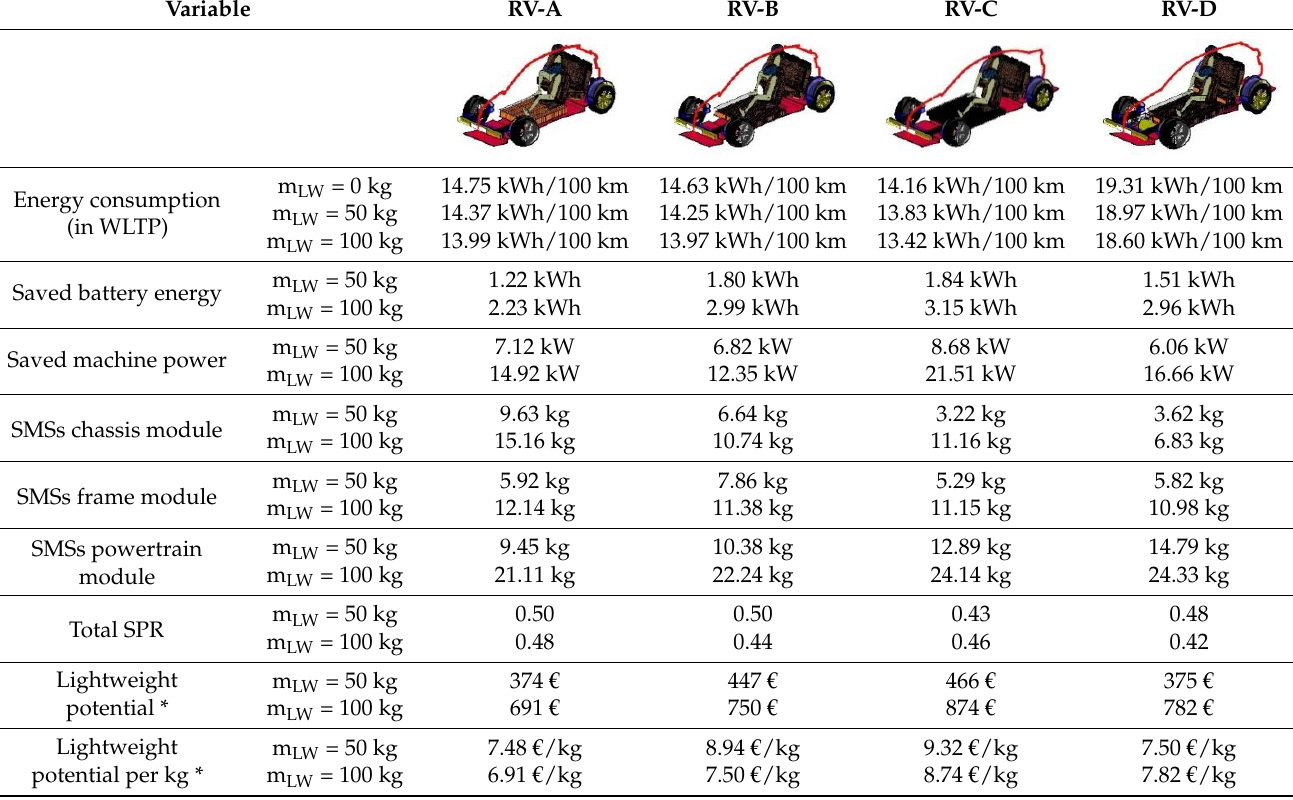
Table 5. Influence of different lightweight measures on energy consumption, required battery energy, and module masses. Variable RV-A RV-B RV-C RV-D